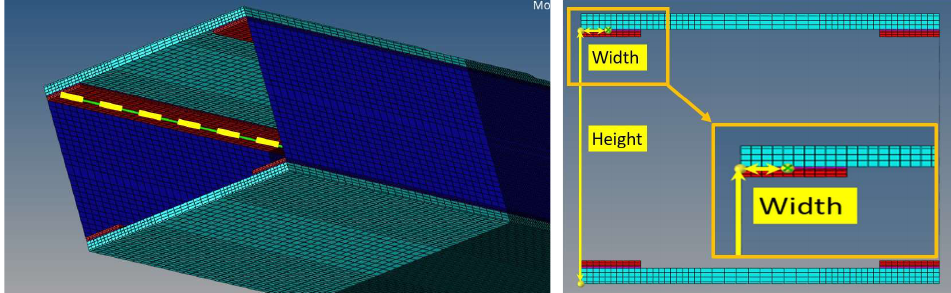
Figure 35. FEM model of the composite beam, with its reference system: H = height, W = width, S = span; integral view ( left ), and view without a lateral wall (C-spar web, ( right )) to show the C-spar caps for all their length.